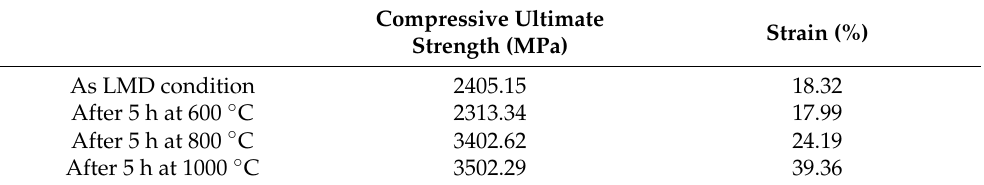
Figure 5. Compression test results, fracture macro morphology and fracture micro morphology of the AlCoCrFeNi components before and after high-temperature treatment: ( a , a1 and a2 ) as-fabricated; heat-treated at ( b , b1 and b2 ) 600 °C; ( c , c1 and c2 ) 800 °C; and ( d , d1 and d2 ) 1000 °C. Table 2. Compression test results of the AlCoCrFeNi components before and after the high-temperature treatments.